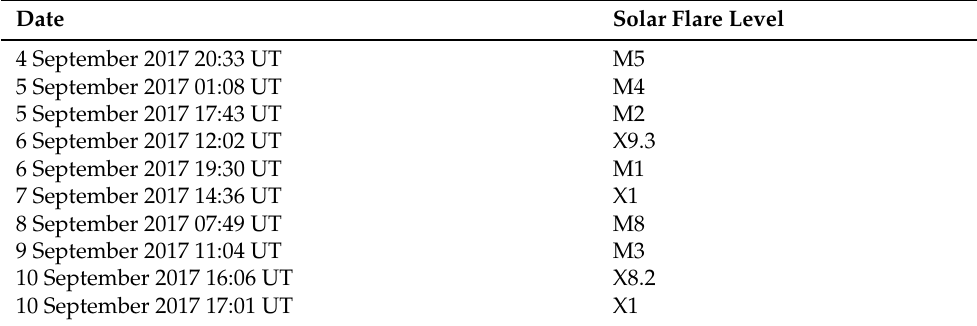
Table 1. The intensity of solar flares in September